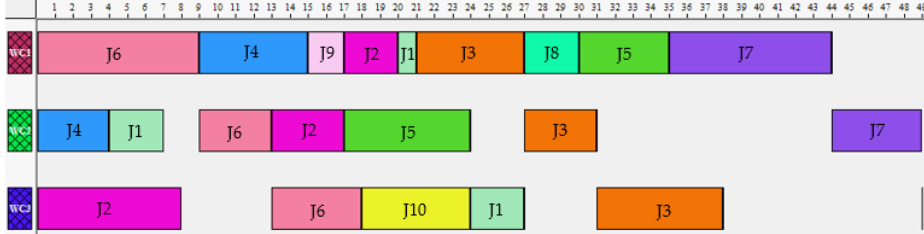
Figure 9. Gantt chart about the best solution found for scenario 3 (about problem instance 27).